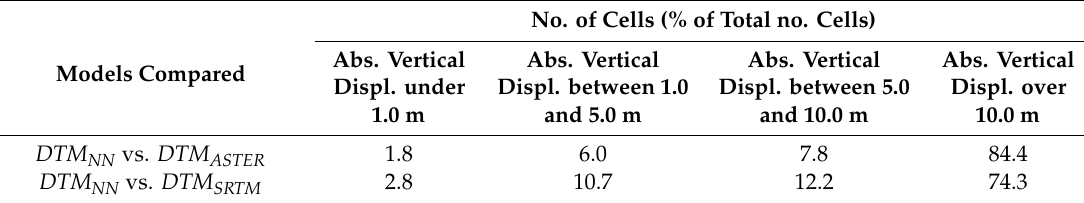
Figure A2. Raster models of vertical displacement between: ( a ) DTM NN and DTM ASTER and ( b ) DTM NN and DTM SRTM . Table A2. Classification of absolute vertical displacement values, at the 21.0 m model